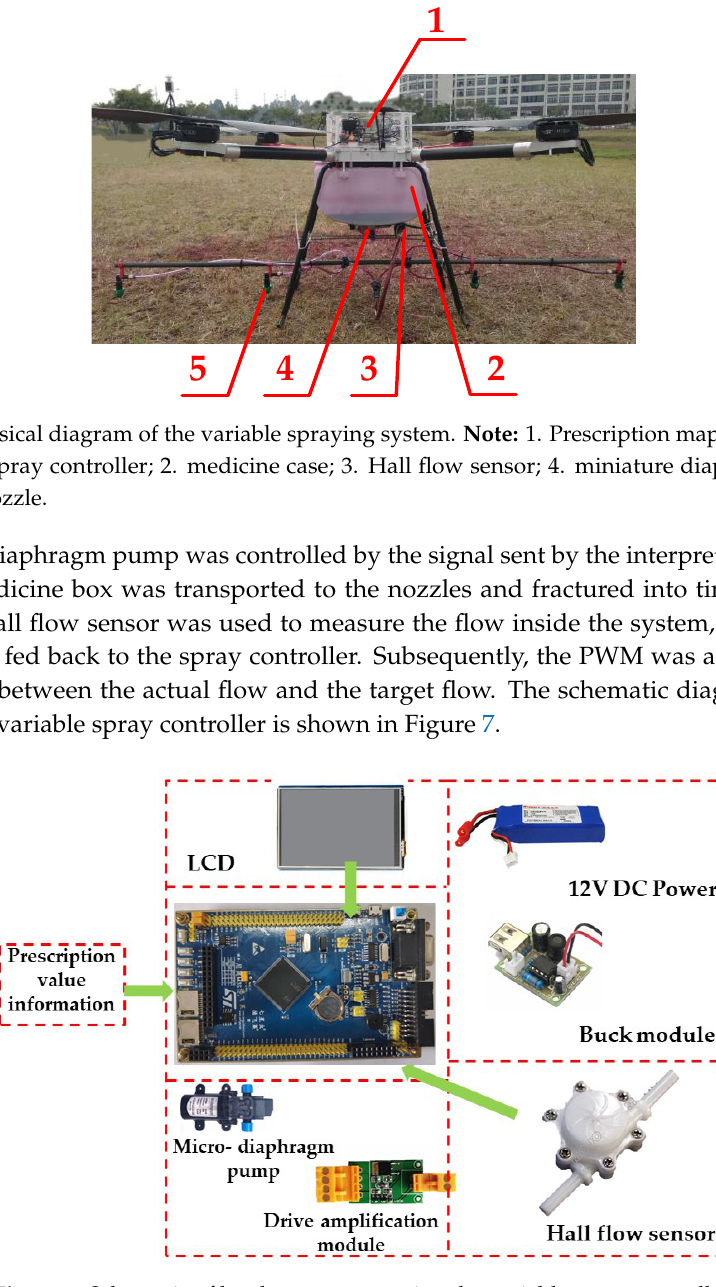
Figure 7. Schematic of hardware representing the variable spray controller.